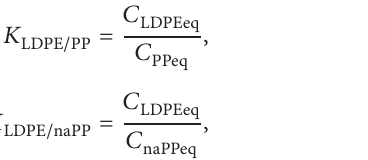
Table 2: High performance liquid chromatography parameters employed in the analysis of diphenyl phthalate (DPP), 2-isopropyl-